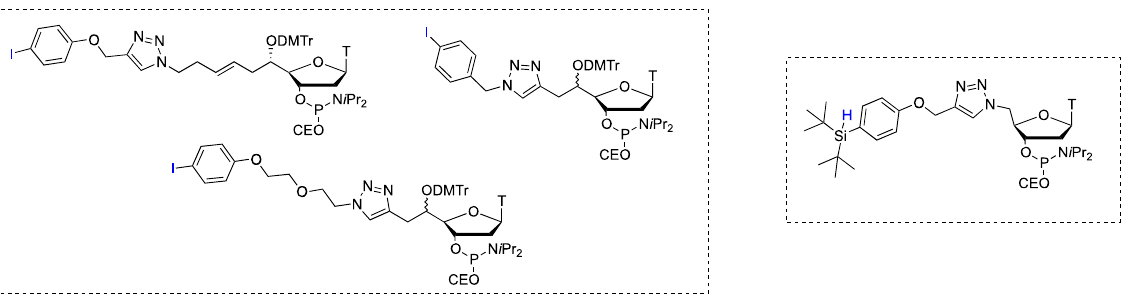
Figure 1. Already functionalized phosphoramidites for 11 C ( left ) or 18 F ( right ) labeling